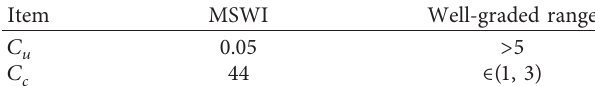
Table 1: Shape parameters of MSWI.